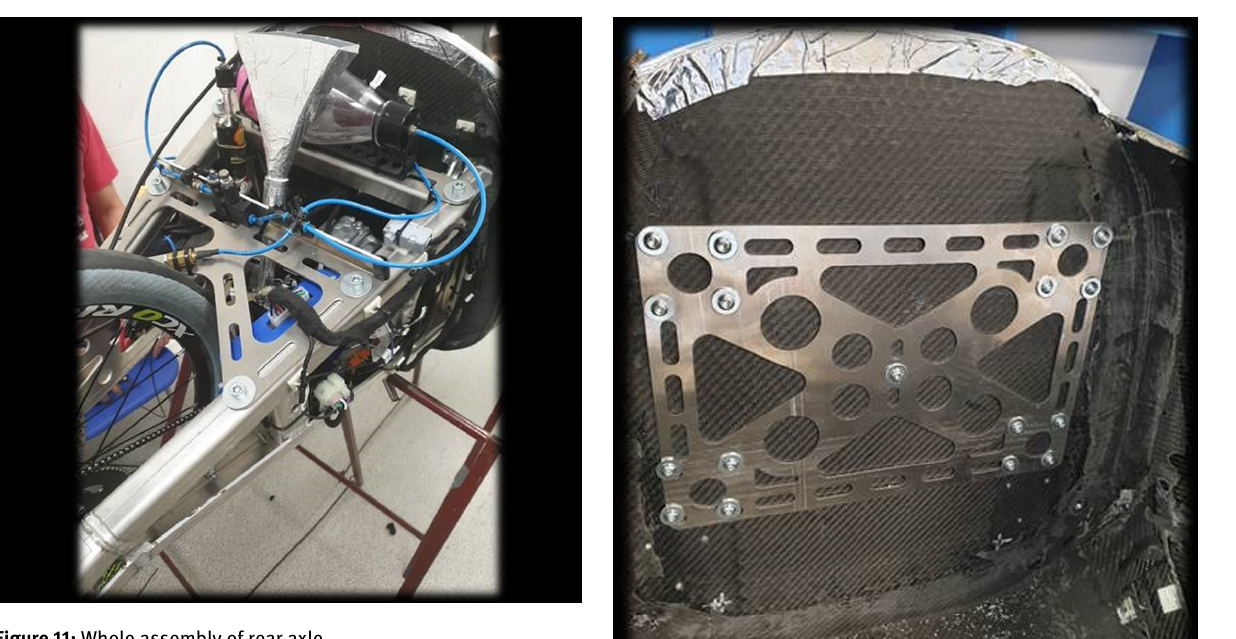
Figure 11: Whole assembly of rear axle.